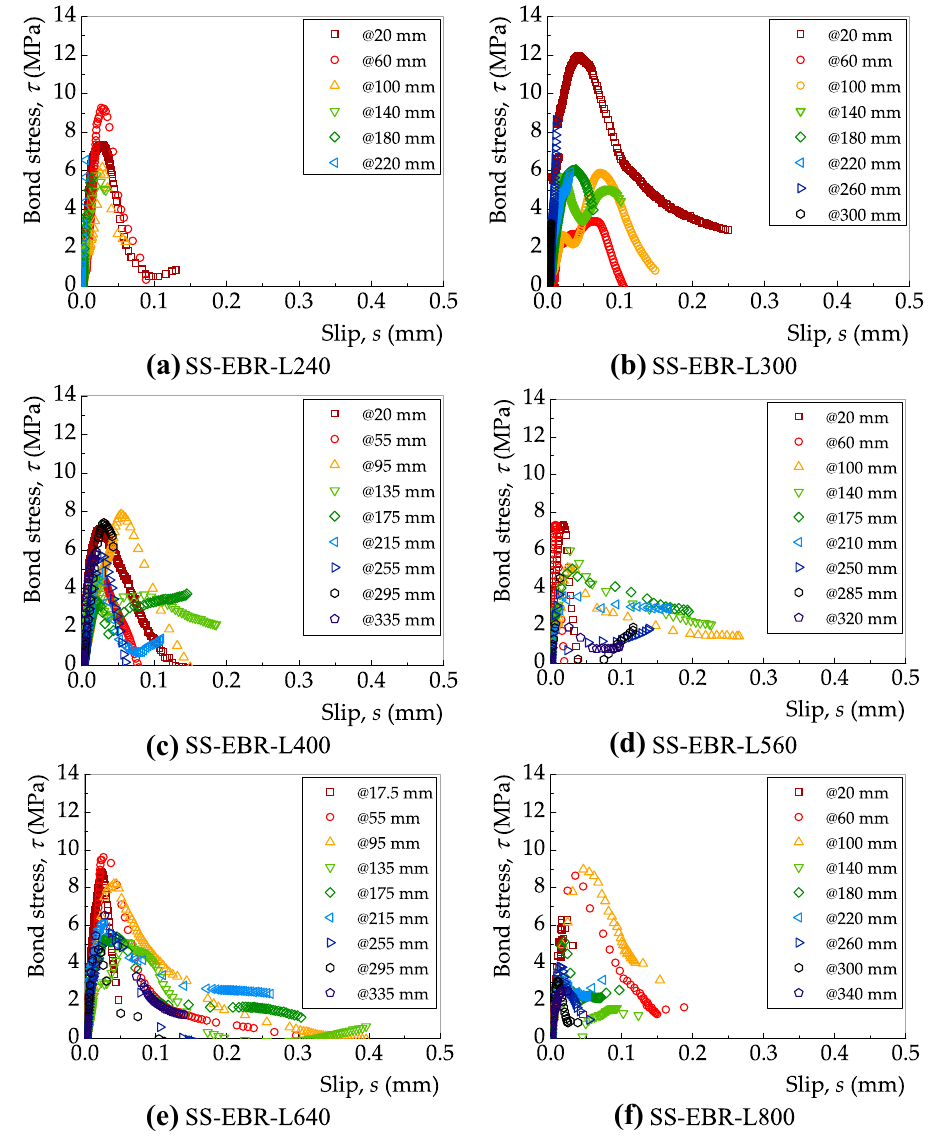
Fig. 13 Interfacial bond–slip relationships of the EBR samples obtained from the strain gauges.